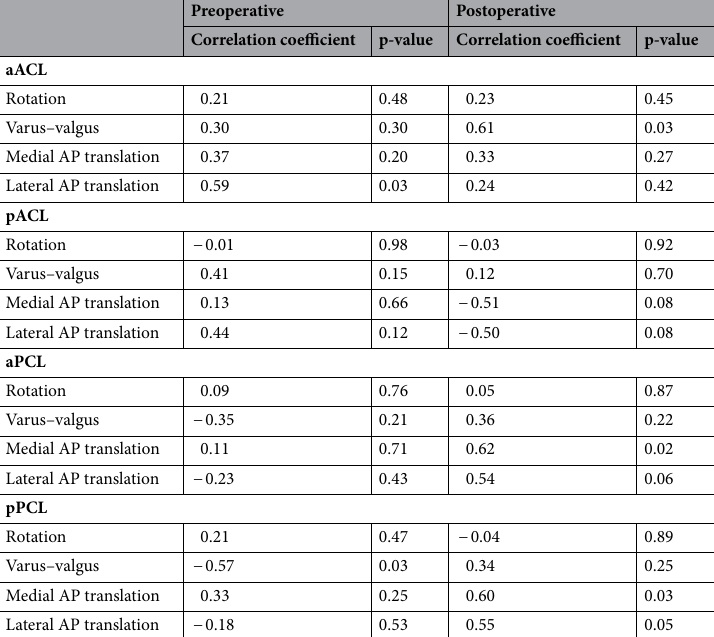
Table 1. Correlation between differences in knee kinematics and cruciate ligament. aACL anteromedial bundle of the anterior cruciate ligament, aPCL posterior bundle of the anterior cruciate ligament, AP anteroposterior, pACL anterolateral bundle of the posterior cruciate ligament, pPCL posteromedial bundle of the posterior cruciate